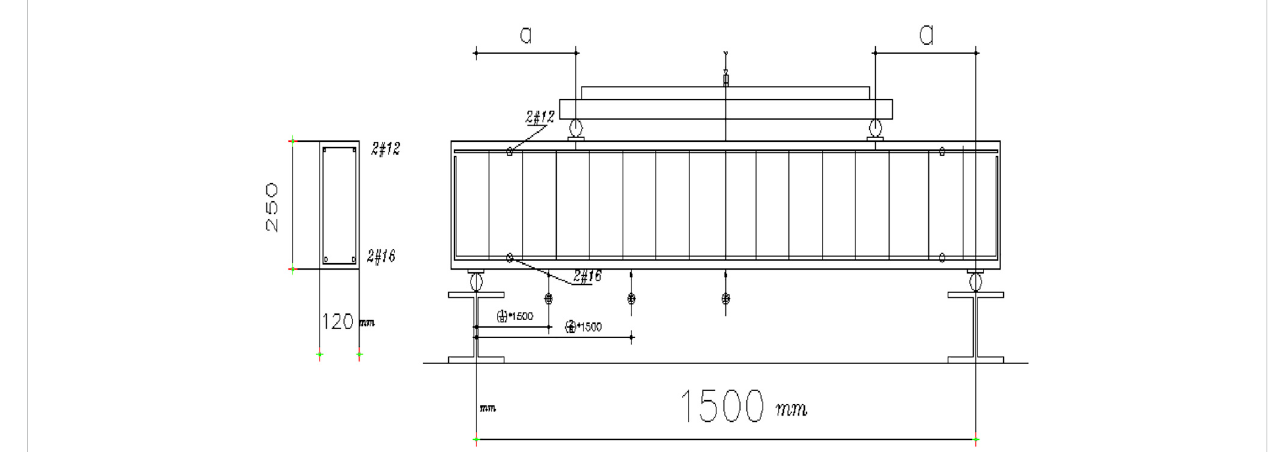
FIGURE 2 Beam specimen geometry.